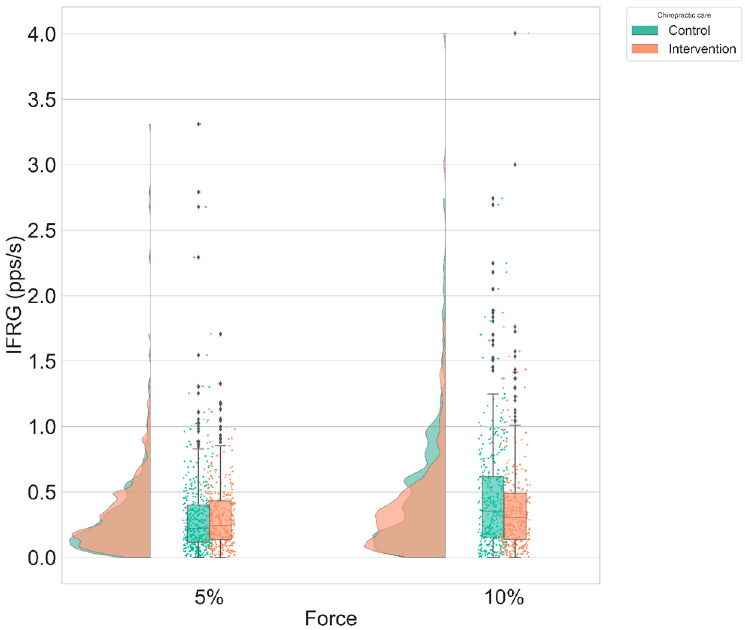
Figure A1. Unmagnified distribution plot of the IFRG after intervention (control vs. spinal manipulation) for “ramp & Maintain” condition adjusted to baseline (Unmagnified Figure 8).